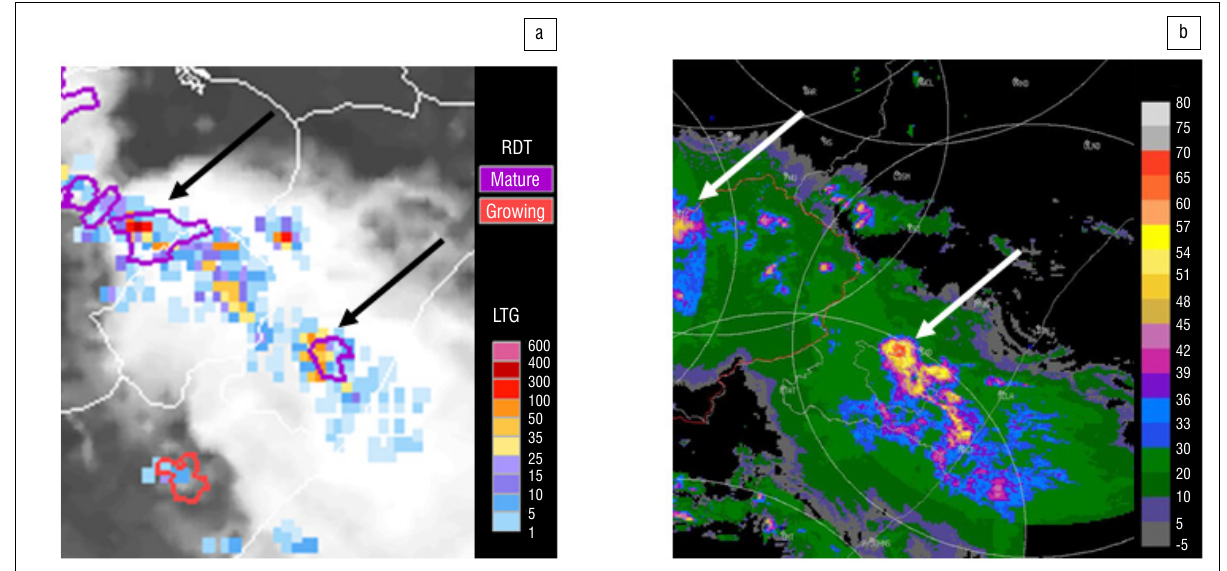
Figure 4: (a) RDT data at 15:30 UTC and lightning from 15:20 to 15:40 UTC and (b) radar reflectivity at 15:30 UTC on 9 October 2012 over the southeastern parts of South Africa.